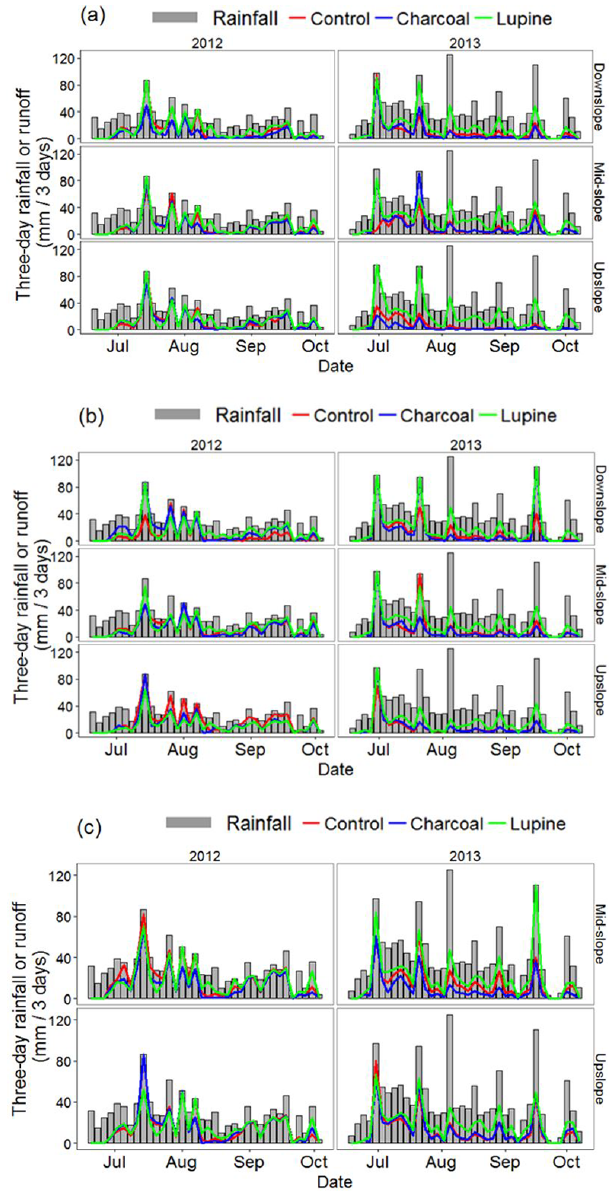
Figure 3. Three-day rainfall and adjusted 3-day runoff depths (ag- gregated over 3 days) from individual plots in different slope posi- tions along Transect 1 (a) , Transect 2 (b) , and Transect 3 (c) .